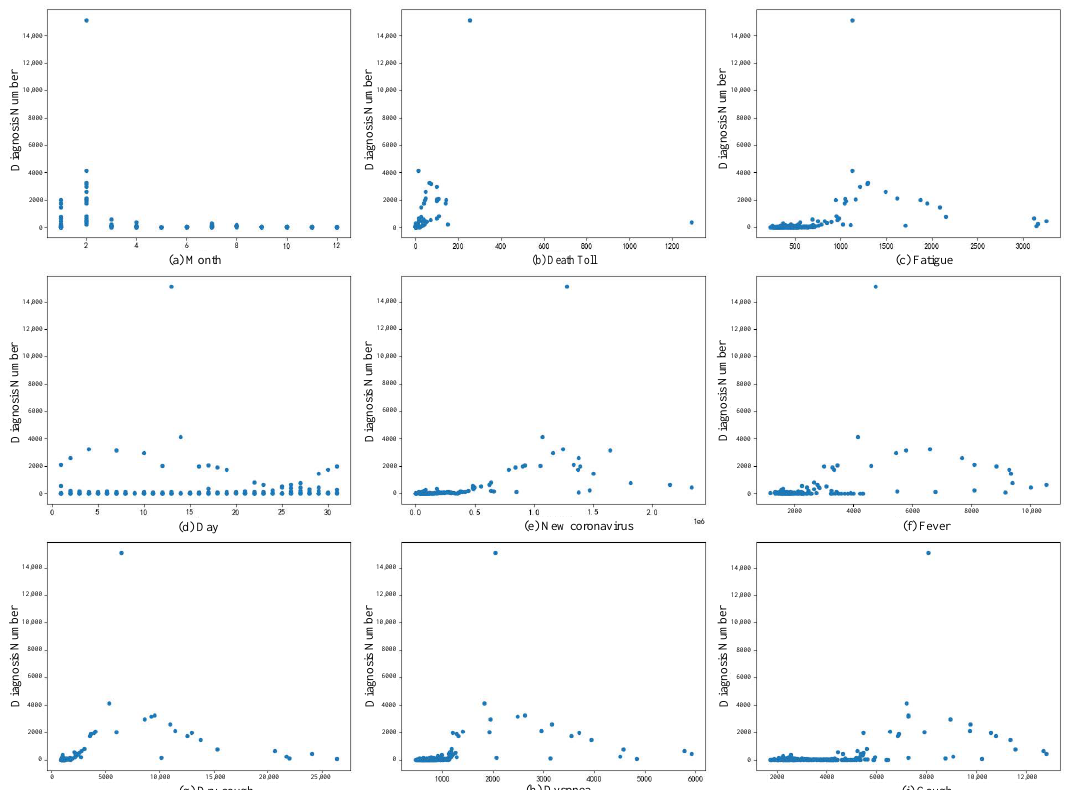
Figure 4. The impact of all attributes on diagnosis numbers. ( a , d ) show the trend of newly diagnosis number by month and day, respectively. ( b ) represents the relationship between the diagnosis numbers and the death toll. ( e ) represents the relationship between the diagnosis numbers and new diagnosis released by the CDC. ( c , f , g , h ) and ( i ) respectively represent the relationship between the diagnosis numbers and Baidu Index data based on keyword search, and they correspond to